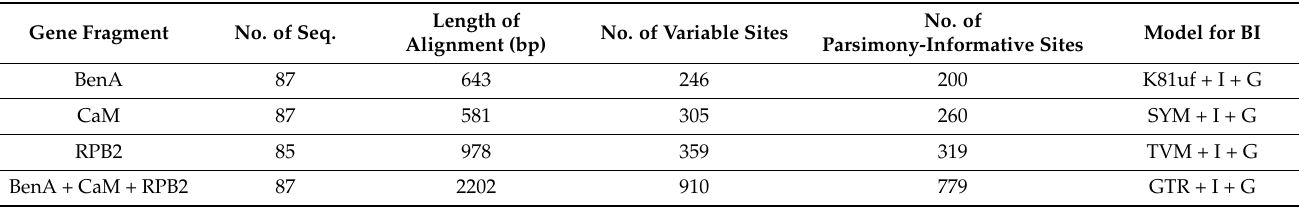
Table 2. Detailed characteristics of datasets of Talaromyces sect. Talaromyces